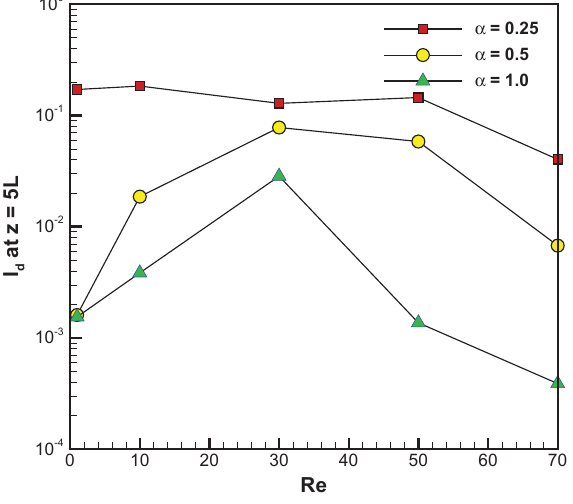
Figure 10. Effect of the Reynolds number on the intensity of segregation at a down-channel position z = 5 L